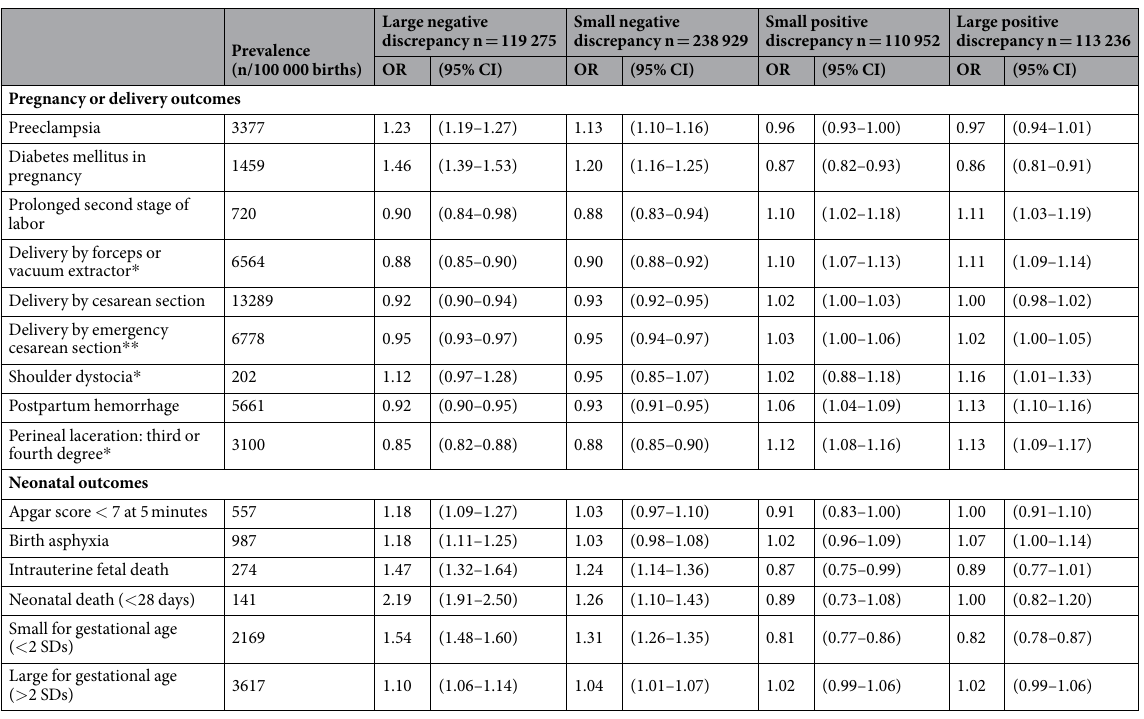
Table 1. Adverse obstetric and neonatal outcomes according to the discrepancy between pregnancy dating methods (n = 1 100 049). Logistic regression-derived crude ORs and 95% CIs for adverse obstetric and neonatal outcomes among all recorded singleton births in Sweden 1995–2010, with documentation of the date of last menstrual period, US-based estimated date of delivery, maternal weight, and height according to the discrepancy between pregnancy dating methods. Negative discrepancy indicates that the EDD by LMP was at an earlier date than was the EDD by US. Positive discrepancy indicates that the EDD by LMP was at a later date. A large negative discrepancy was defined as below the 10 th percentile, and a large positive discrepancy as above the 90 th percentile in the discrepancy distribution. The reference category (n = 517 657) was a discrepancy within 2 days of the median. The intermediate groups were defined as small negative and small positive discrepancies. * Excluding deliveries by cesarean section; ** Excluding elective cesarean section. OR, odds ratio; CI, confidence